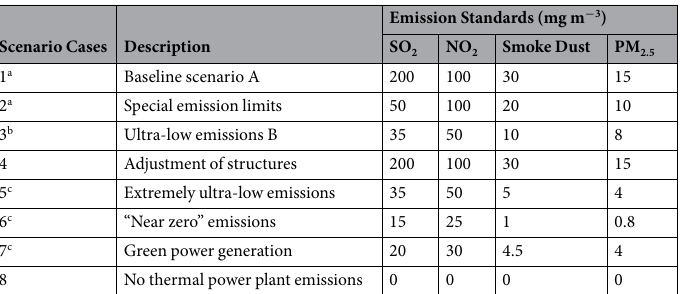
Scenario Cases Description